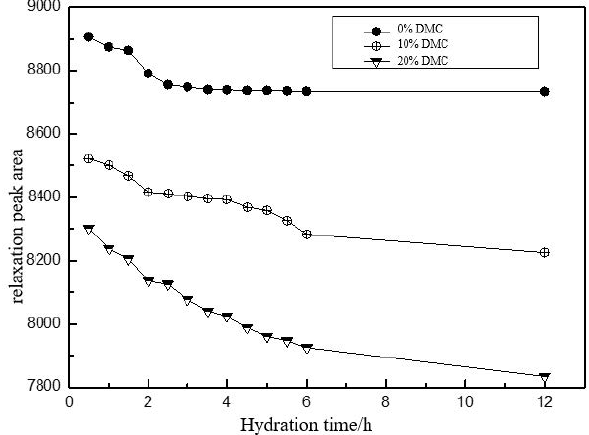
Figure 6. Changes in the relaxation peak area with